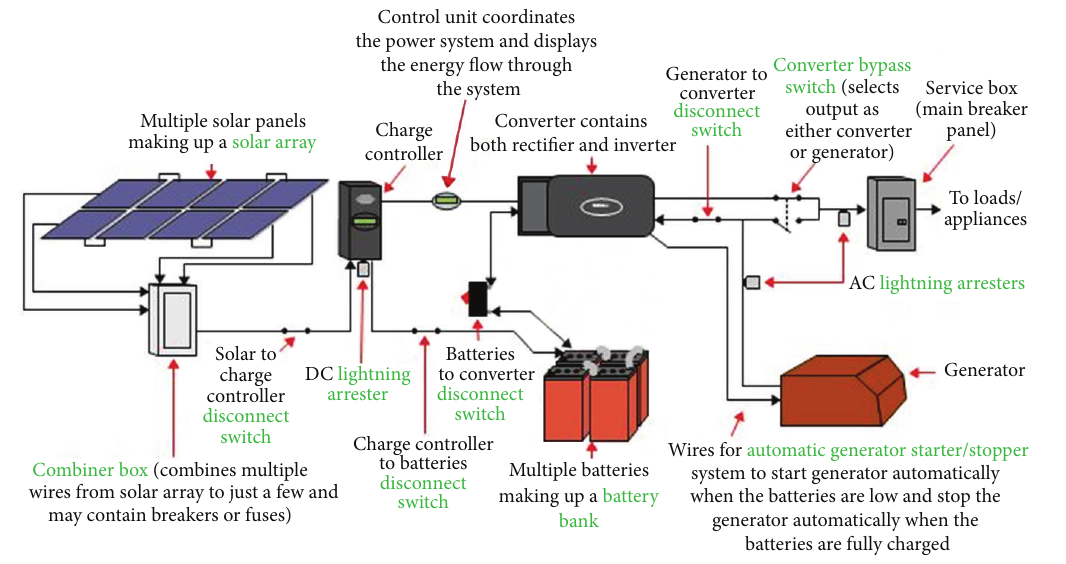
Figure 4: Photovoltaic hybrid power system structure [33].